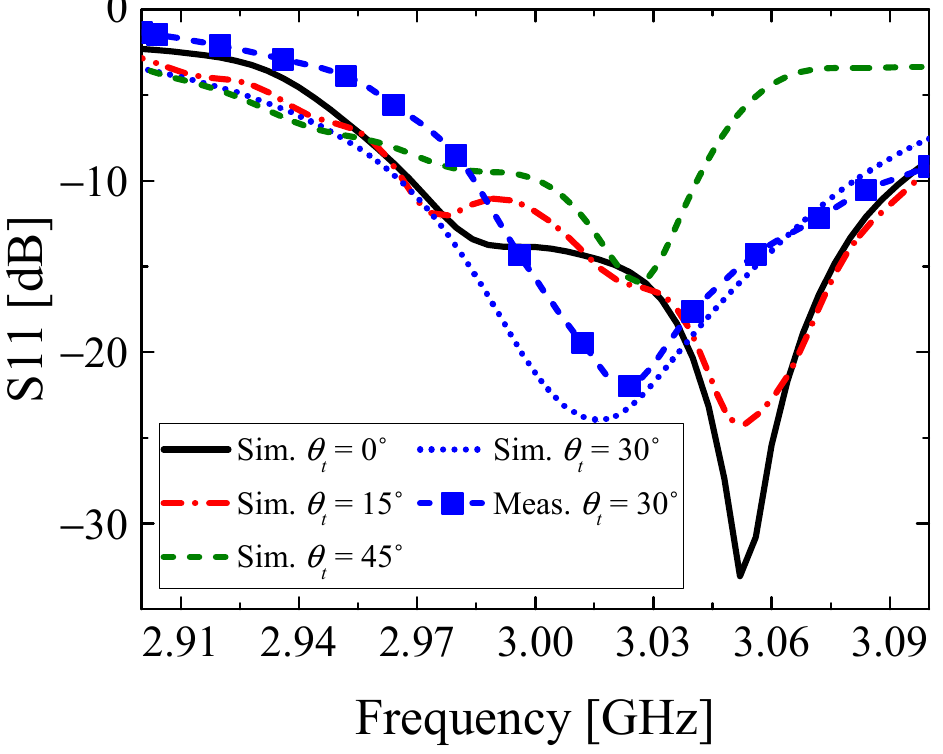
Figure 10. Input reflection coefficients (S11) according to the frequency for each scanned beam case. Three-dimensional radiation patterns of the proposed antenna for each target direction are also shown in Figure 11. As we can see, the FPC antenna can scan the main beam well by properly adjusting the AMC configurations. To show the beam-scan performance more clearly, we plotted the contours of the radiation patterns on both the H- and E-plane for each scanning case in Figure 12. The specific performances of the proposed antenna at the design frequency are summarized in Table 2. As is described, the antenna can scan the main beam in the target direction with well-maintained high gain and a relatively narrow half-power beamwidth (HPBW). Good agreement between expected and experimental results verifies the validity of our design